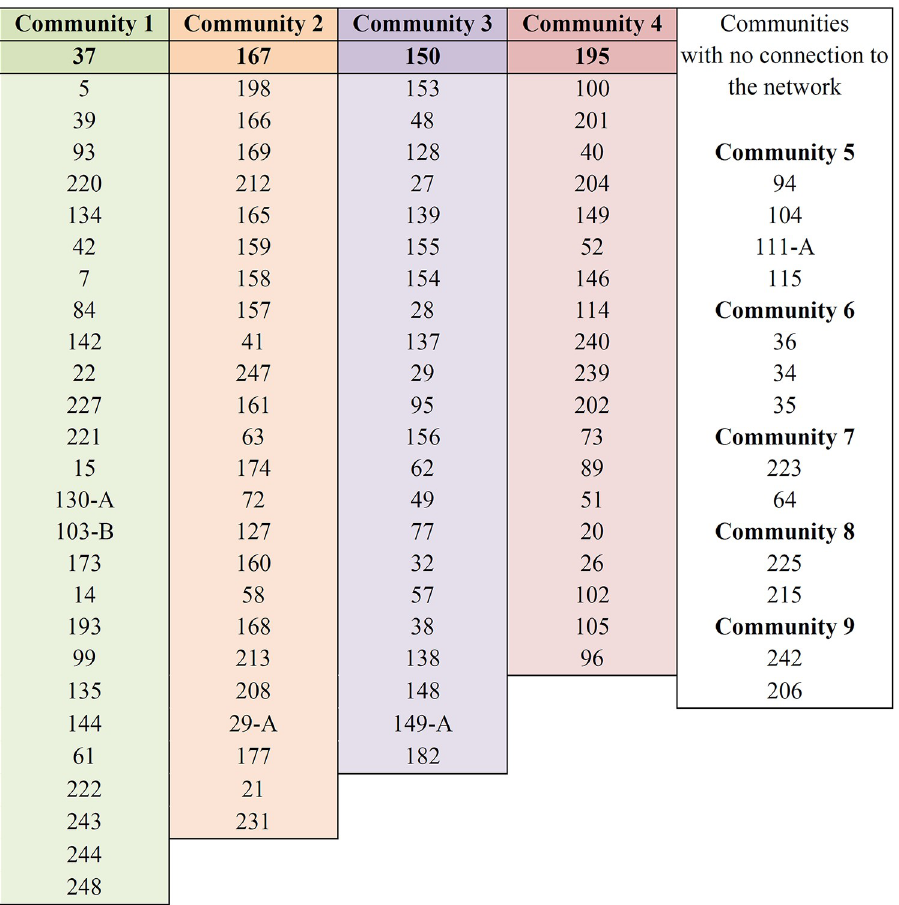
Fig 2. Mapped communities of articles (ranked by